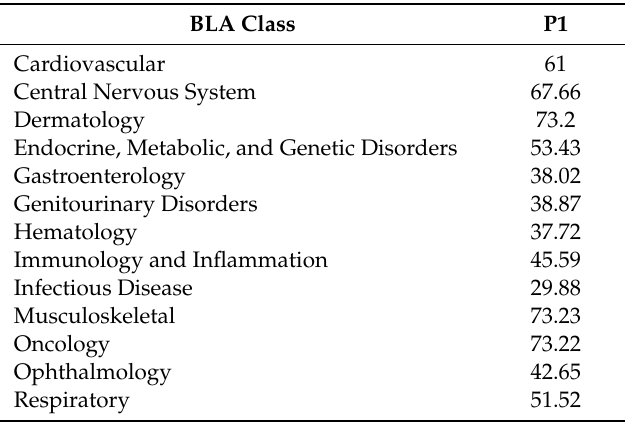
Table 14. Development period in P1 by BLA drug class for the whole period (1970–2017).